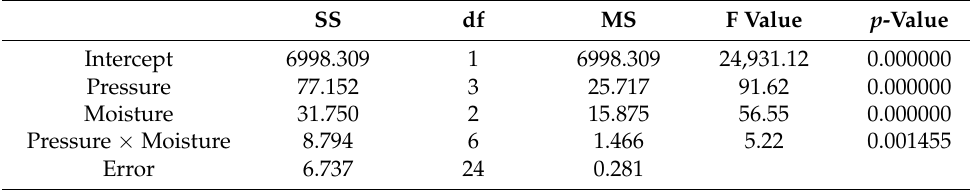
Table 2. Two-way analysis of variance (ANOVA)—silphium.